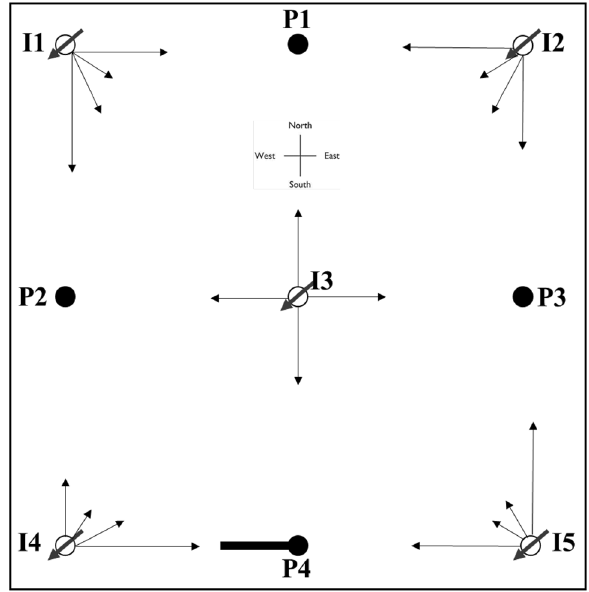
Fig. 25 Distribution of f ij in case VI after applying D-CRMP. P 4 is horizontal well, which is drilled toward the West. Each black arrow and its length represents the connectivity and magnitude,